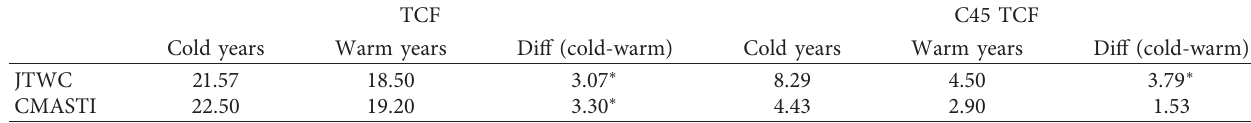
∗ The difference is statistically significant at the 95% confidence